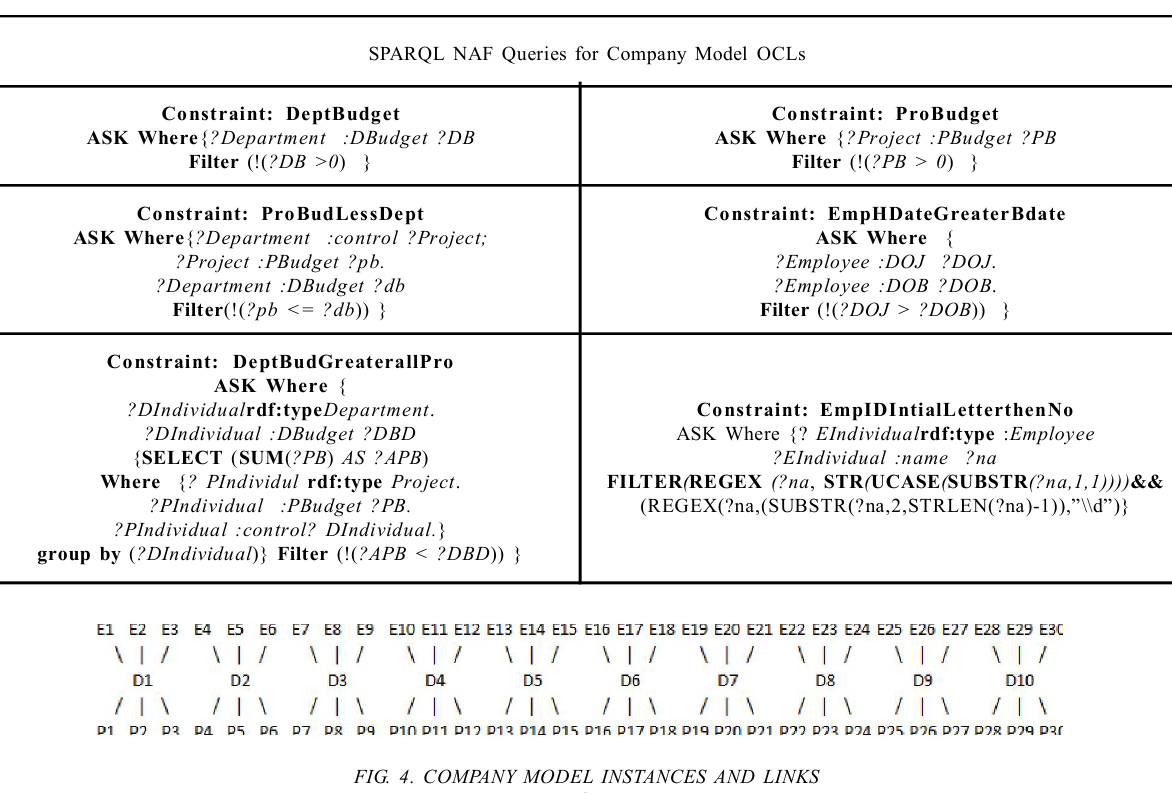
FIG. 4. COMPANY MODEL INSTANCES AND